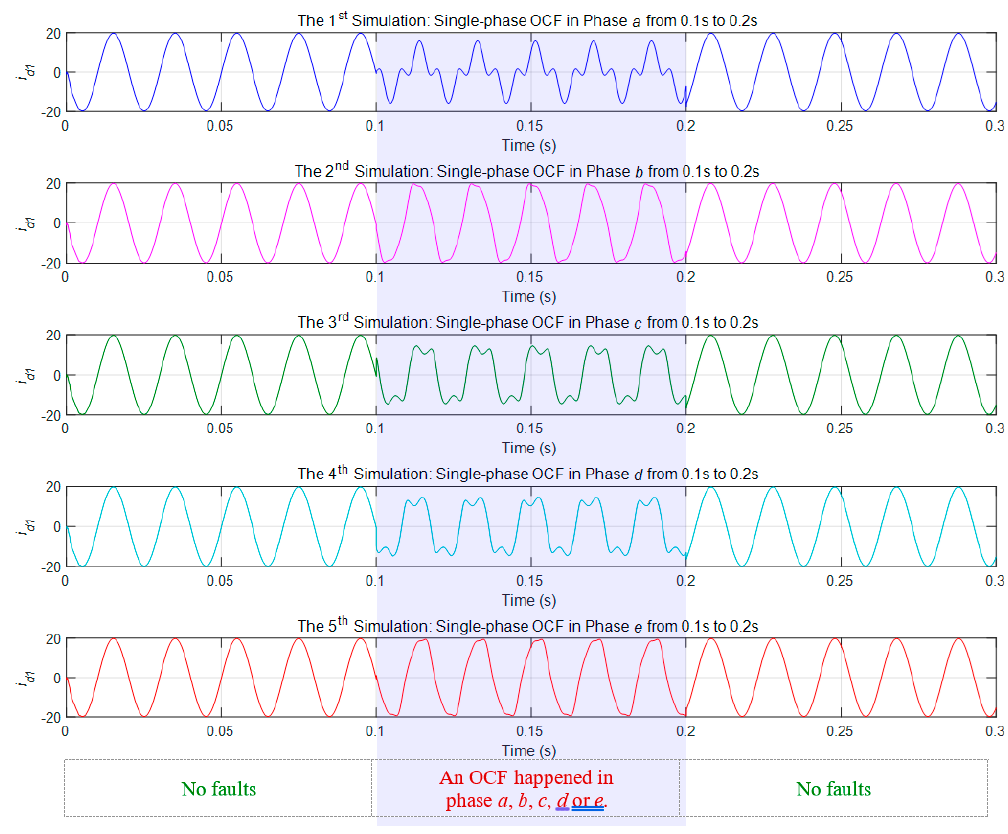
Figure 15. Direct-axis components of five-phase fundamental currents in five simulations with single-phase OCF occurring in each phase of the FP-PMSG.